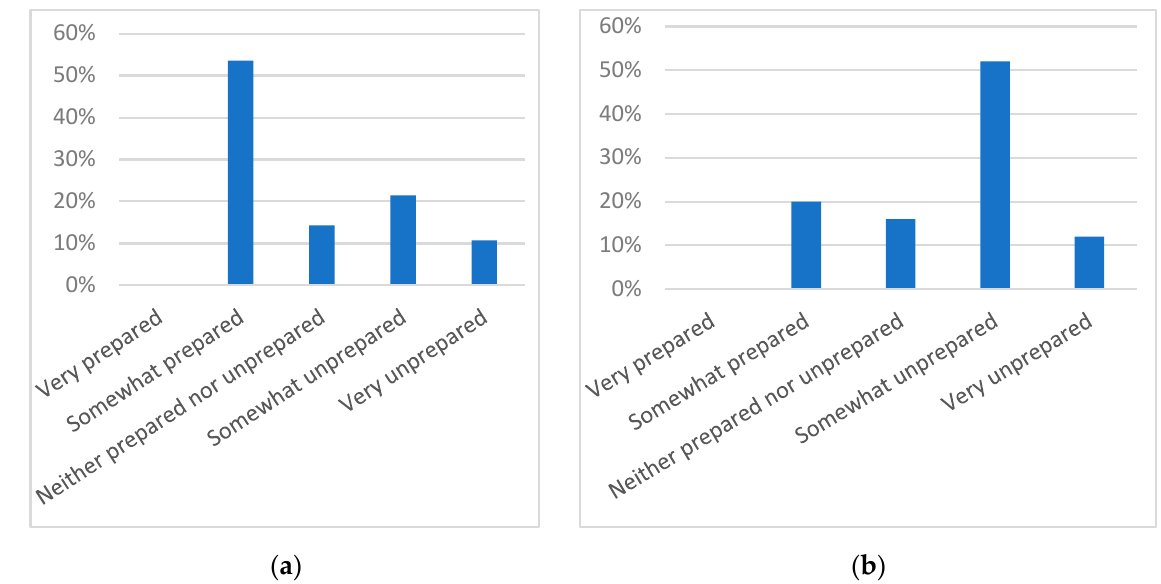
Figure 7. How prepared are shipping companies in meeting the IMO 2021 requirements and consequently addressing cyber security? ( a ) Europe; ( b ) Asia.